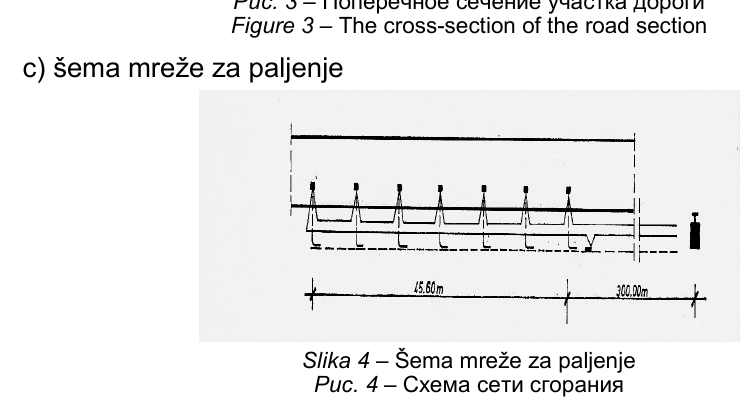
Figure 3 – The cross-section of the road section